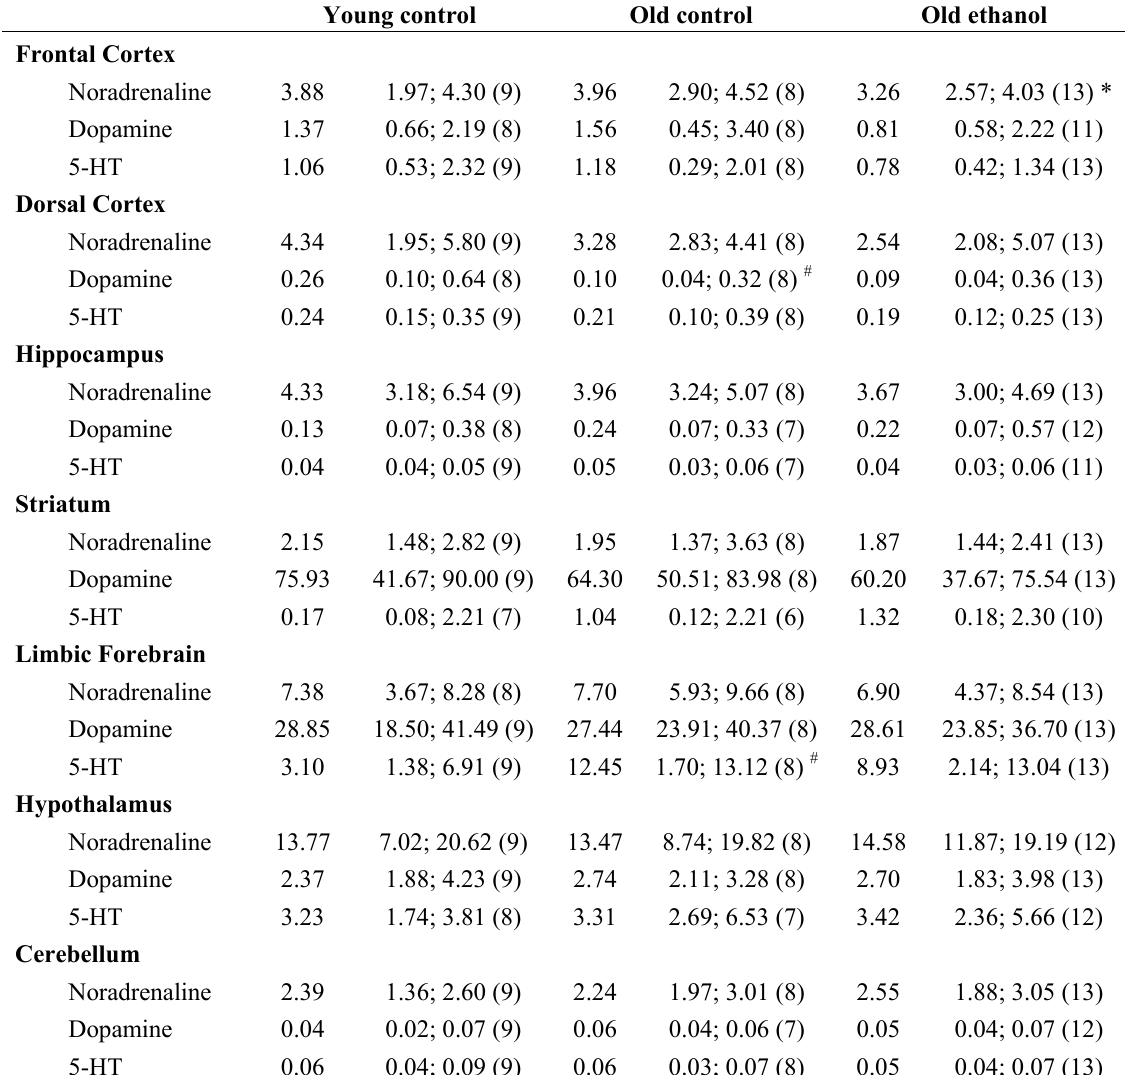
Table 3. Concentrations of monoamines in different brain areas of young control, old control, and old ethanol-exposed AA